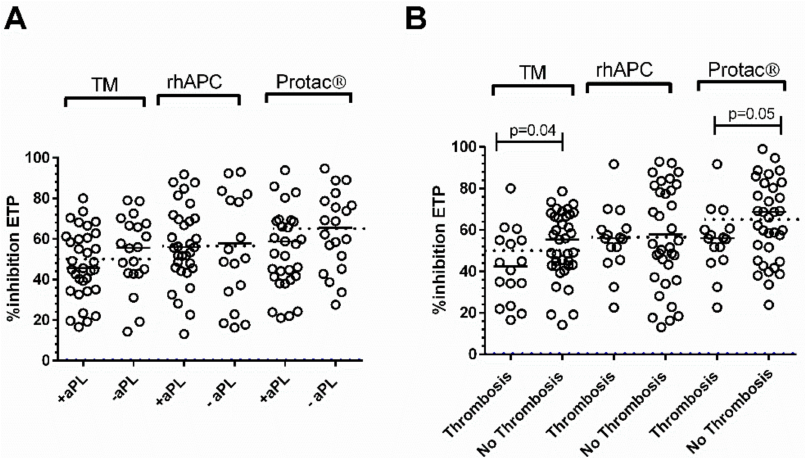
Figure 4. APCr with TM, rhAPC, and Protac ® in patients with SLE stratified according to ( A ) aPL status and ( B ) thrombotic history. Dotted lines indicate the cut off for each method